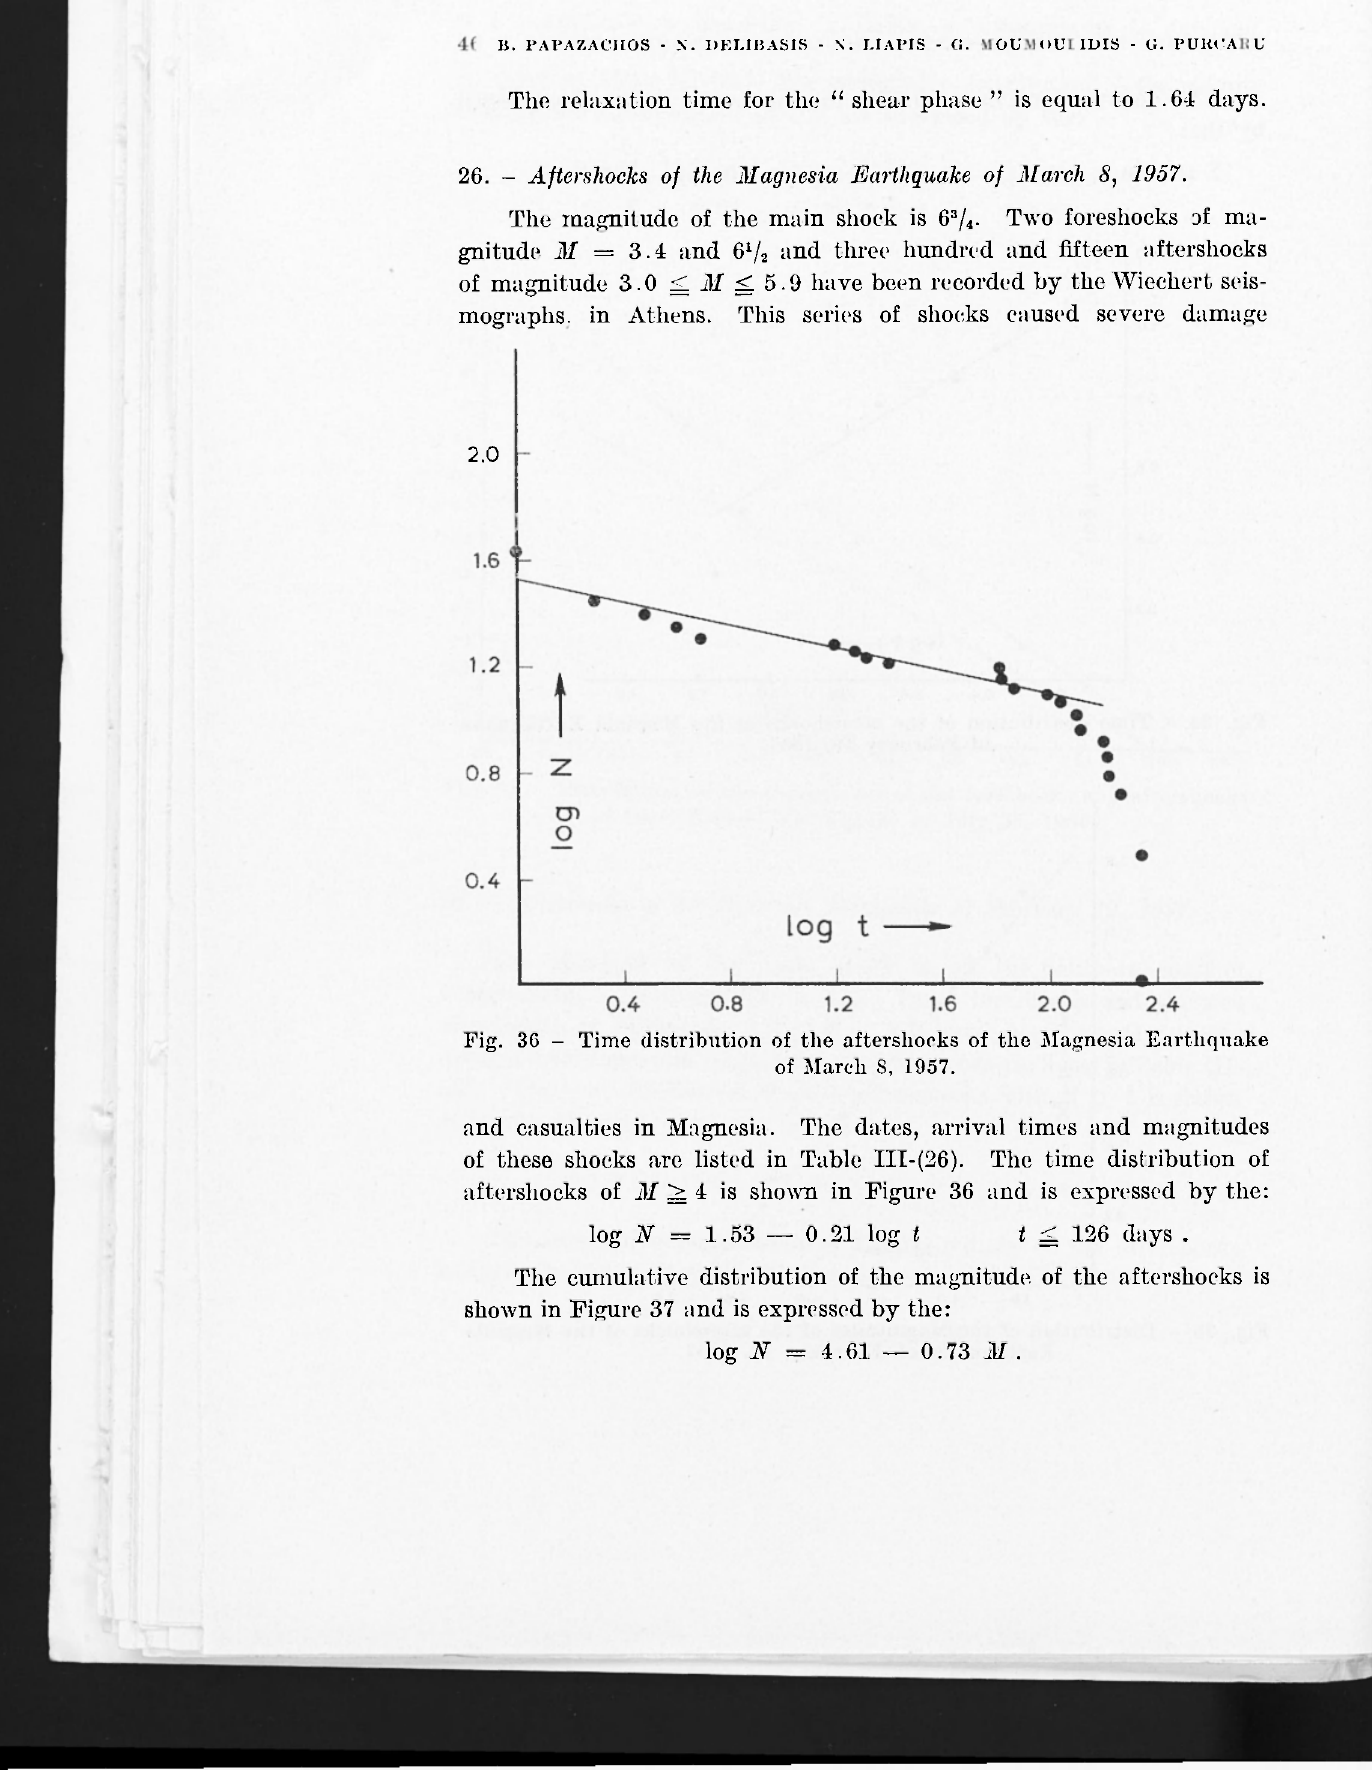
Fig. 36 - Time distribution of the aftershocks of the Magnesia Earthquake of March 8,